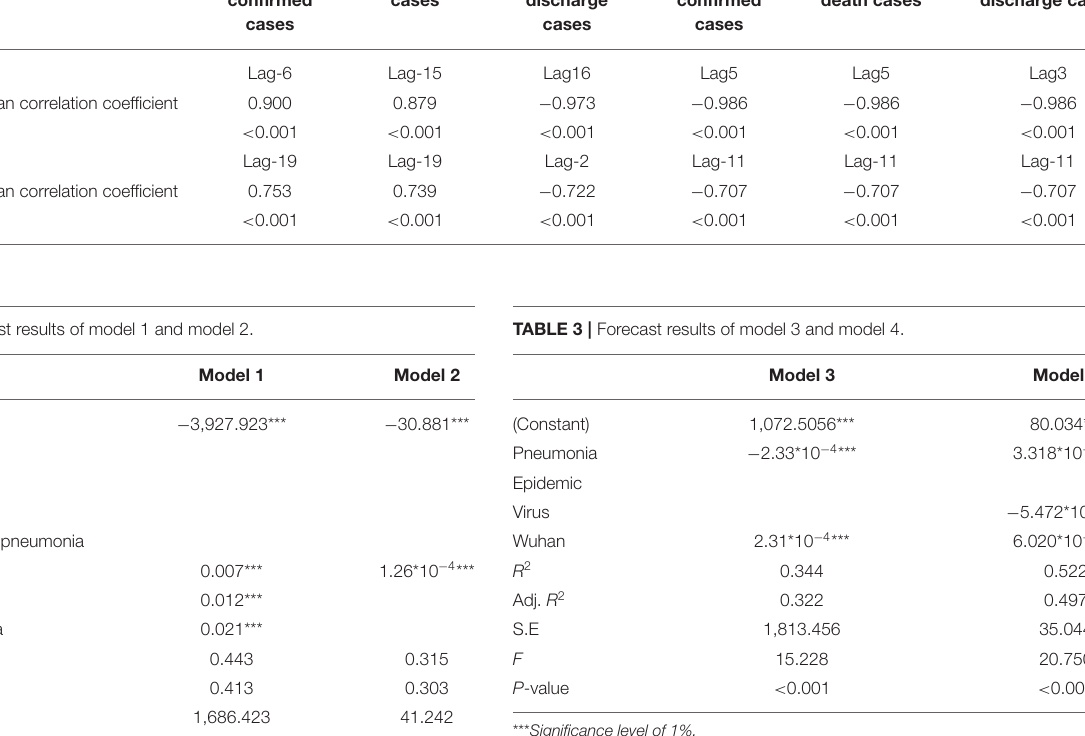
Model 3 ( Table 3 ): four SMI-related keywords were used to predict new confirmed cases. Model 4 ( Table 3 ): four SMI-related keywords were used to predict new death